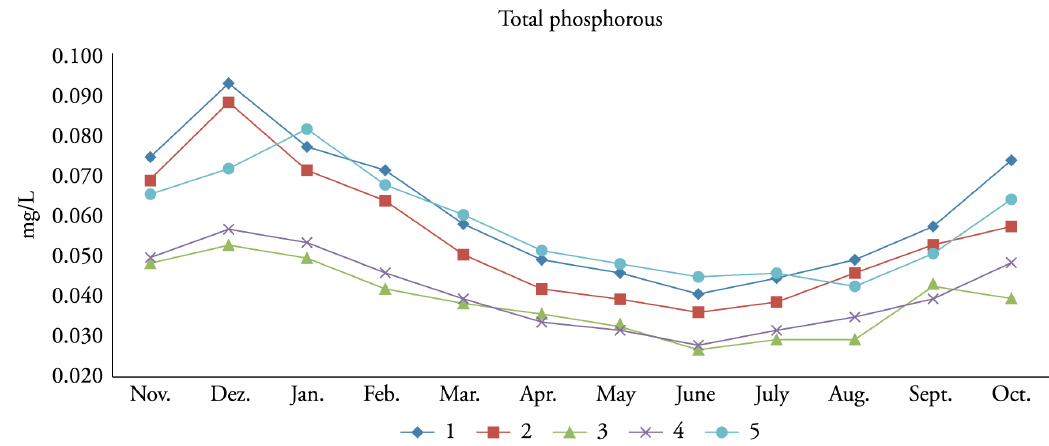
Figure 3. Total Phosphorous among the monitoring.